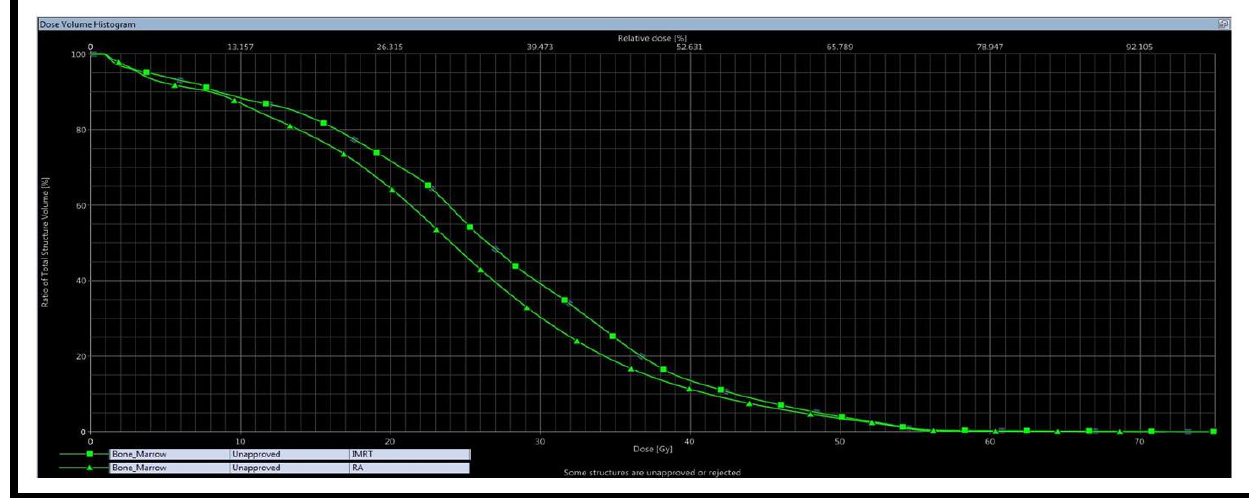
Figure 3: Dose-volume histogram (DVH) for pelvic bone marrow of patient’s plans showing better sparing with volumetric-modulated arc therapy (VMAT) than intensity-modulated radiotherapy